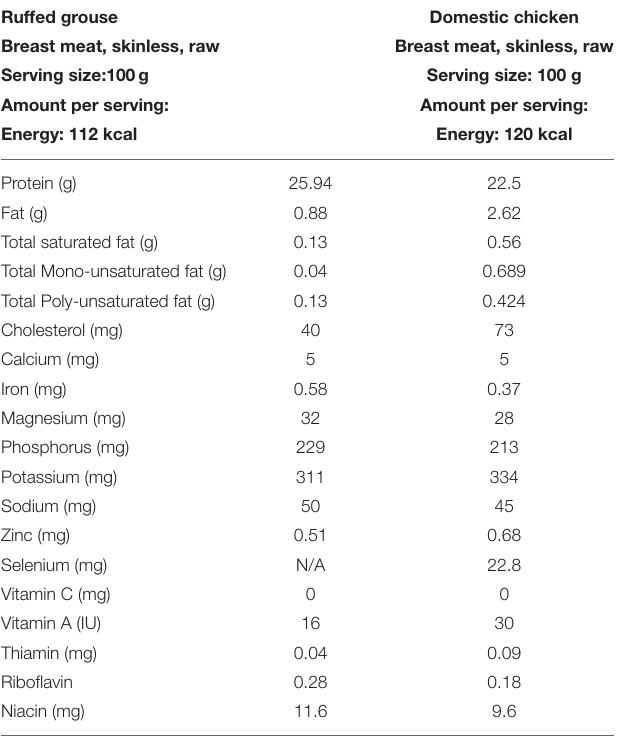
TABLE 4 | Ruffed grouse nutrient content compared to domestically raised chicken meat. Ruffed grouse Domestic chicken